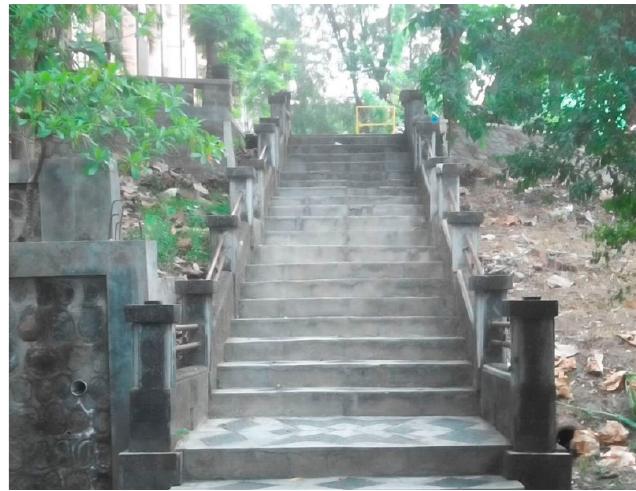
Figure 1. The outdoor staircase used for the study.